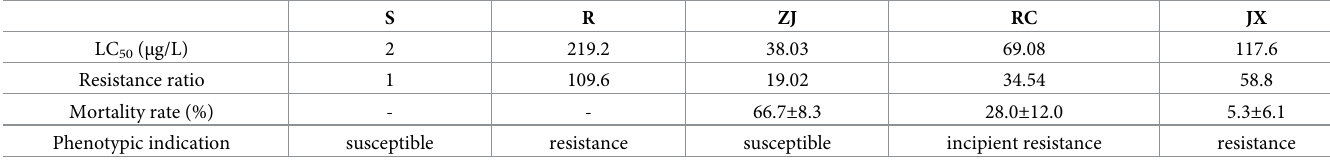
Table 1. Sample information of five strains